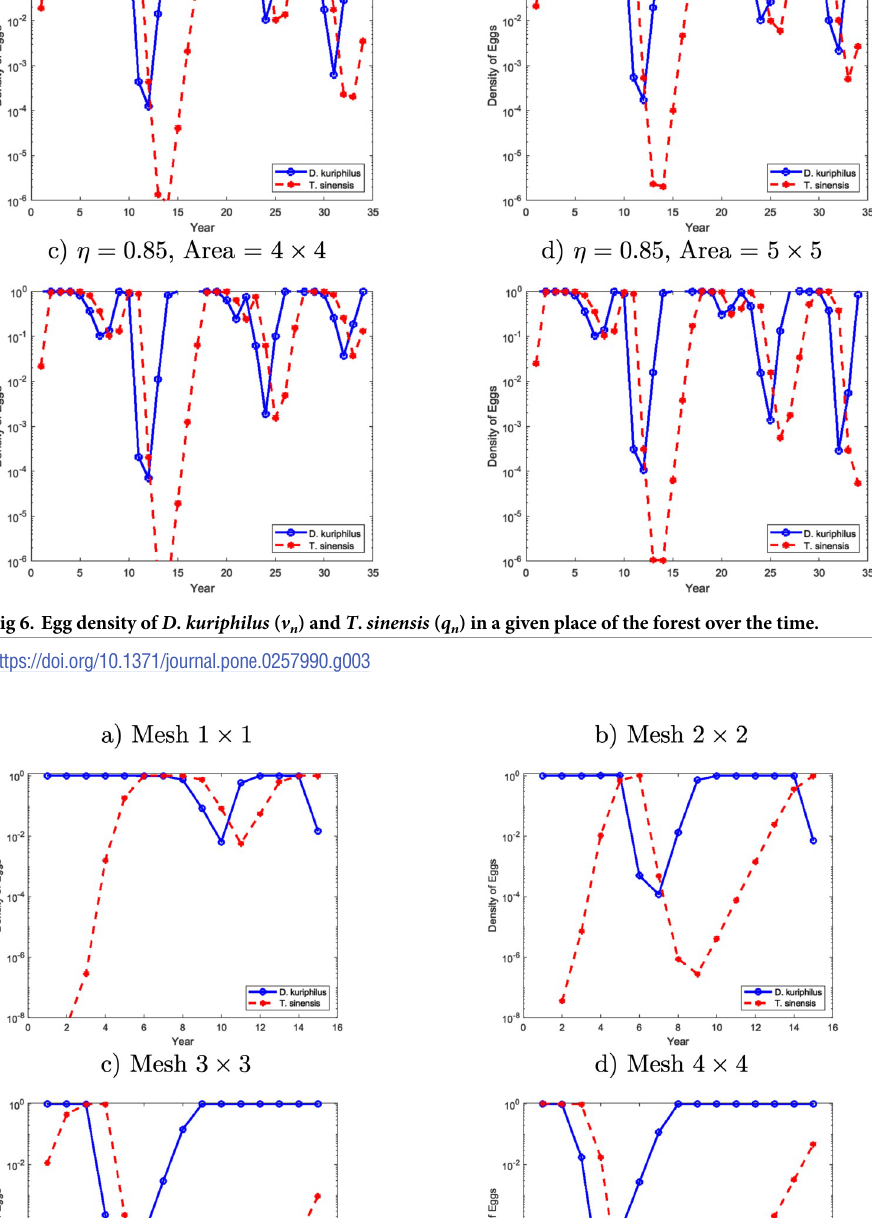
Fig 7. Egg density of D . kuriphilus ( v n ) and T . sinensis ( q n ) at a fixed position in the computational domain as a function of time, after multiple simultaneous releases of T . sinensis performed at year 0 from stations placed on a regular